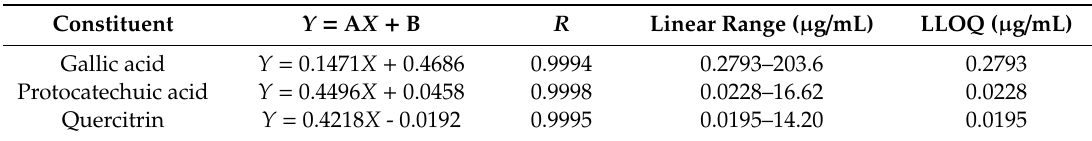
Table 1. Regression equation, linear range, and lower limit of quantification (LLOQ) of the three constituents in rat plasma.